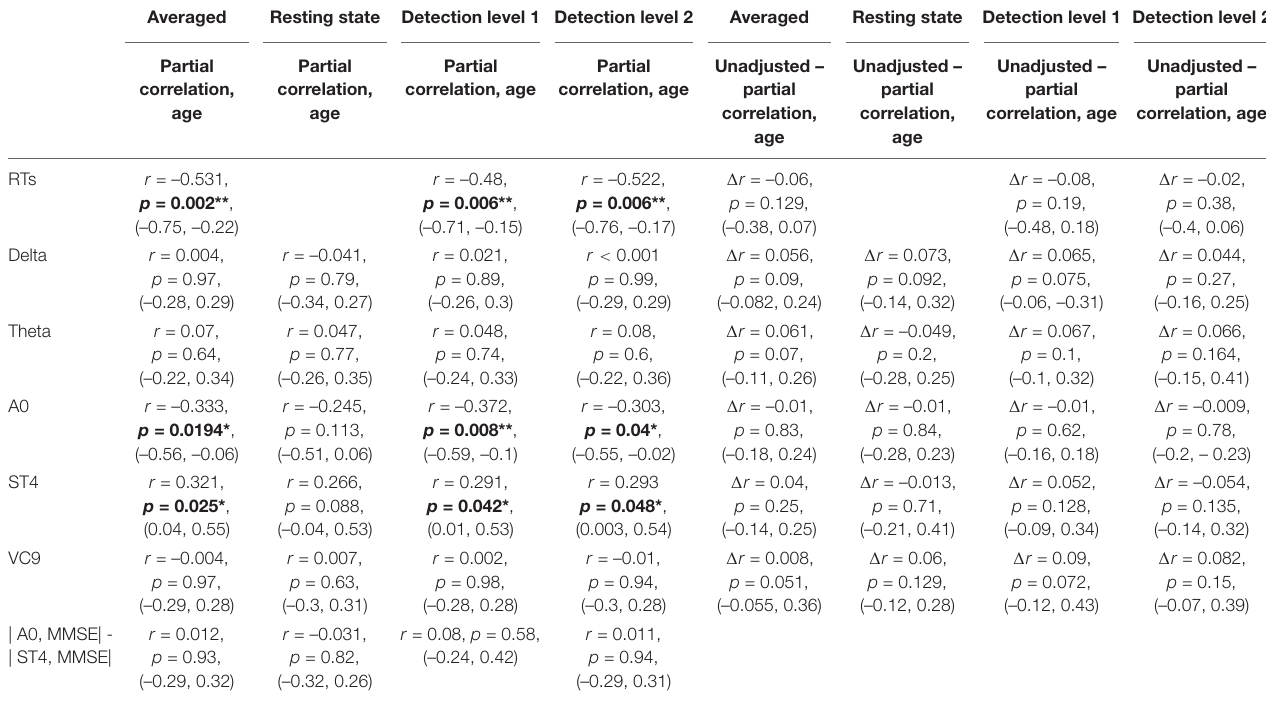
TABLE 3 | Partial Pearson r coefficients (first row of each cell), p -values (second row), and 95% CI (third row) of the correlations between individual MMSE scores and EEG features (and reaction times), controlled for age as a function of task (averaged across tasks, resting state, detection level 1, and detection level 2), and the difference between correlation coefficients and Cis, the partial correlations, and the unadjusted correlations, as calculated by the bias-corrected and accelerated (BCa) bootstrap